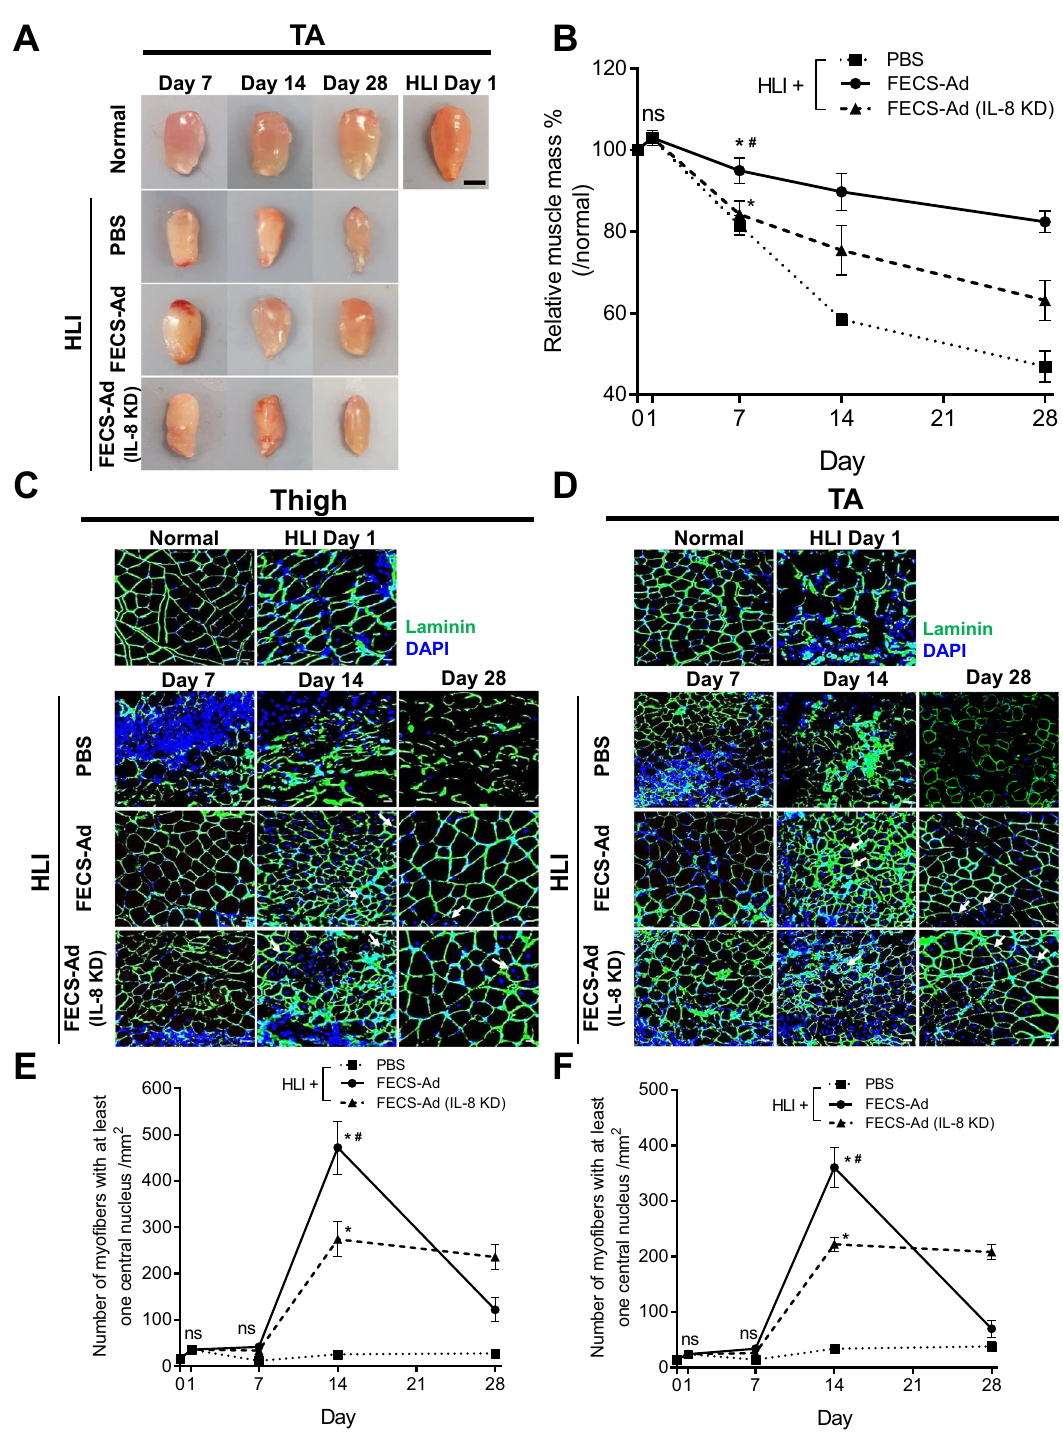
Fig. 9 Roles of IL-8 in the tissue regenerative potential of FECS-Ad in mouse hindlimb ischemia. Ischemic thigh and TA muscles from PBS, FECS-Ad, or IL-8-silenced FECS-Ad-treated mice were prepared followed by immuno fl uorescence. A Representative TAs at appropriate times after ischemic surgery are shown in the photos. n = 4 per group. Scale bar, 2 mm. B Time kinetics of TA weights of each group 1, 7, 14, and 28 days after surgery. ns not signi fi cant among PBS, FECS-Ad, and FECS-Ad (IL-8 KD) group, * p < 0.0001 compared to PBS group, # p < 0.0001 compared to FECS-Ad (IL-8 KD) group (two-way ANOVA). n = 4 per group. Laminin staining of C ischemic thigh and D TA of each group at 1, 7, 14, and 28 days post-surgery. Nuclei were stained with DAPI. Scale bar, 20 μ m. n = 5 per group. Quanti fi cation of muscle fi bers with at least one centralized nuclei in E ischemic thigh and F TA. ns not signi fi cant among PBS, FECS-Ad, and FECS-Ad (IL-8 KD) group, * p < 0.0001 compared to PBS group, # p < 0.0001 compared to FECS-Ad (IL-8 KD) group (two-way ANOVA). n = 5 per group. All data are presented as mean ±